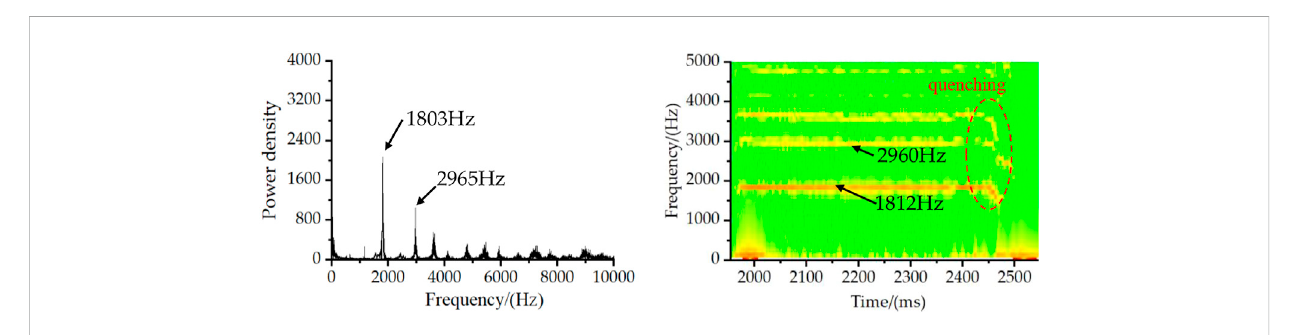
FIGURE 11 Results of operating at ER = 1.0 and l w = 4 mm.